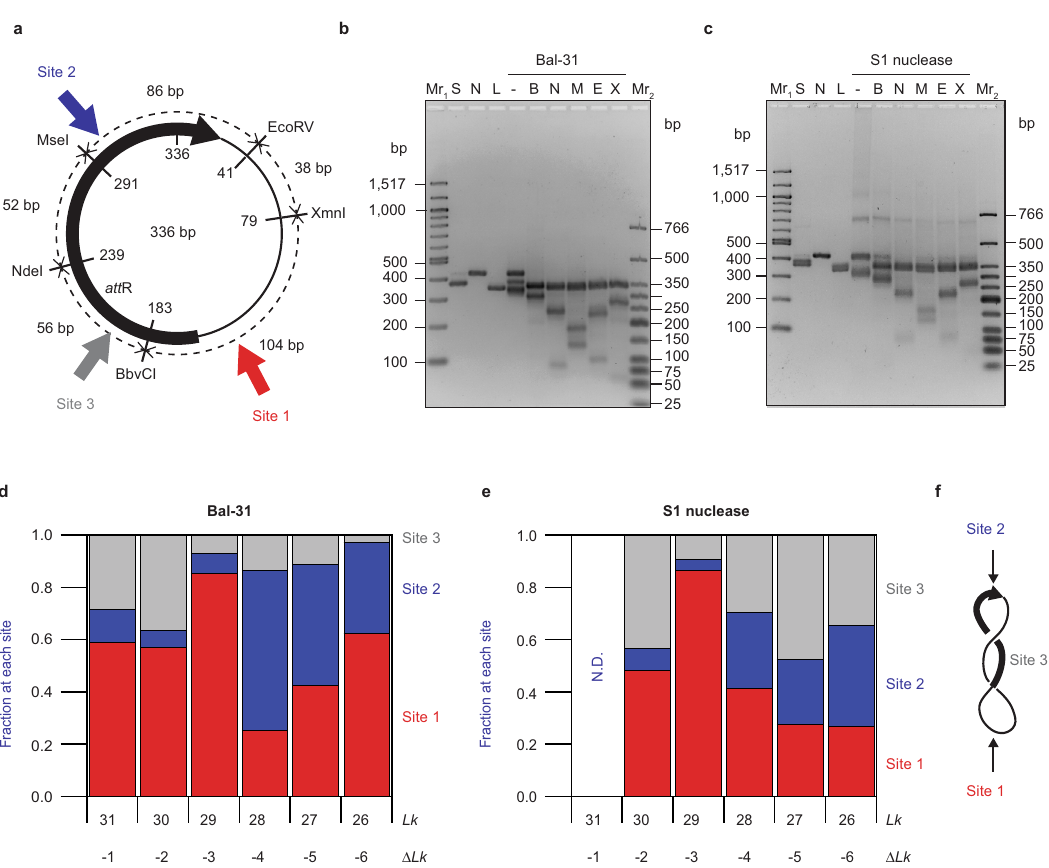
Fig. 3 Bal-31 and S1 nuclease cleave at speci fi c DNA sites containing exposed bases. a Map of the 336 bp minicircle sequence showing the positions of the restriction enzymes used, the location of the three major Bal-31/S1 nuclease cleavage sites, and the att R integrase site. The numbers on the inside of the circle indicate the designated start/end of the minicircle sequence (see “ Methods ” ) and also the positions of each restriction site along the listed sequence. Dashed lines indicate the distances between each restriction cleavage site. Intrinsic curvature in att R is centered around the MseI site (Supplementary Fig. 1). b Minicircle DNA was cleaved with Bal-31, deproteinized, then subsequently cleaved with each of the restriction enzymes, and the products were separated by agarose gel electrophoresis. The 336 bp Lk = 29; Δ Lk = − 3; σ = − 0.095 topoisomer is shown. Mr 1 : 100 bp DNA ladder; Mr 2 : low molecular weight DNA ladder; S: supercoiled (336 bp Lk = 29; Δ Lk = − 3), N: nicked 336 bp minicircle; L: 336 bp minicircle linearized by EcoRV; -, B, N, M, E, X: minicircle incubated with Bal-31 for 1 min followed by incubation with a second restriction enzyme as indicated (-: no second enzyme; B: BbvCI; N: NdeI; M: MseI; E: EcoRV; X: XmnI). This assay was performed at least two times for each topoisomer with very similar results. c Mapping of S1 nuclease cleavage sites (336 bp; Lk = 29; Δ Lk = − 3 topoisomer is shown). The experiment was performed following the same protocol as for Bal-31. This assay was performed once for each topoisomer. d Relative Bal-31 cleavage at each of the three sites as a function of Lk . e Relative S1 nuclease cleavage at each of the three sites as a function of Lk . N.D. not determined. f Model showing localization of sites 1 and 2 to the superhelical